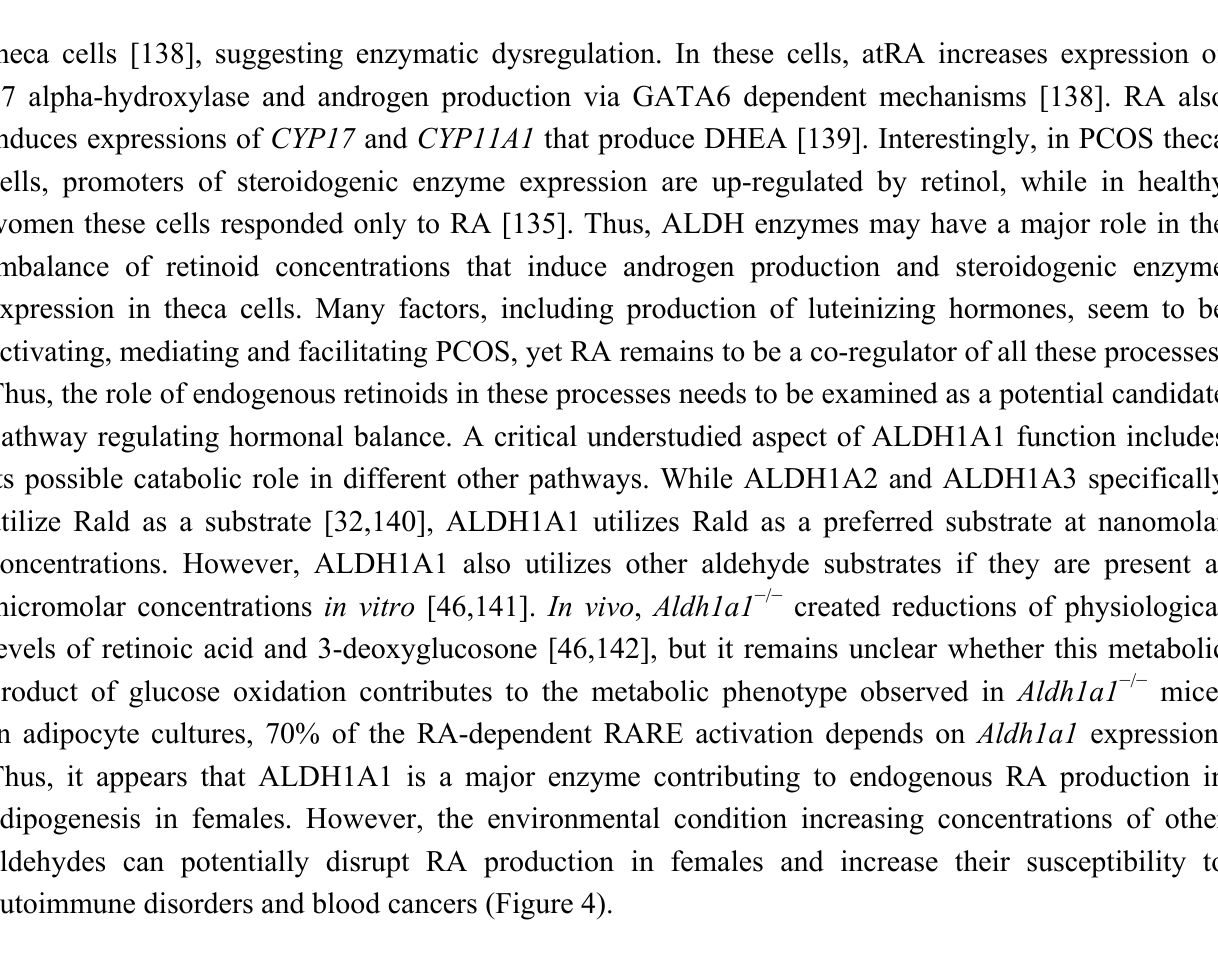
Figure 5. Schematic presentation of sex hormone production in gonads and peripheral tissues. Sex hormones are secreted from the male and female gonads. The testes secrete testosterone into the blood stream while in the ovaries aromatase converts testosterone to estradiol prior to secretion into the blood stream. In the peripheral adipose tissue, aromatase converts testosterone to